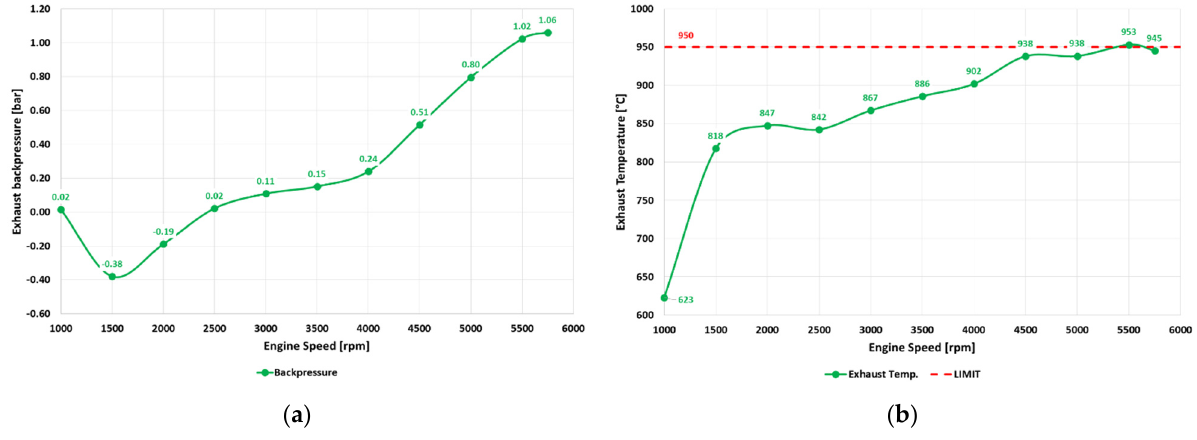
Figure 13. ( a ) Exhaust backpressure and ( b ) exhaust temperature.